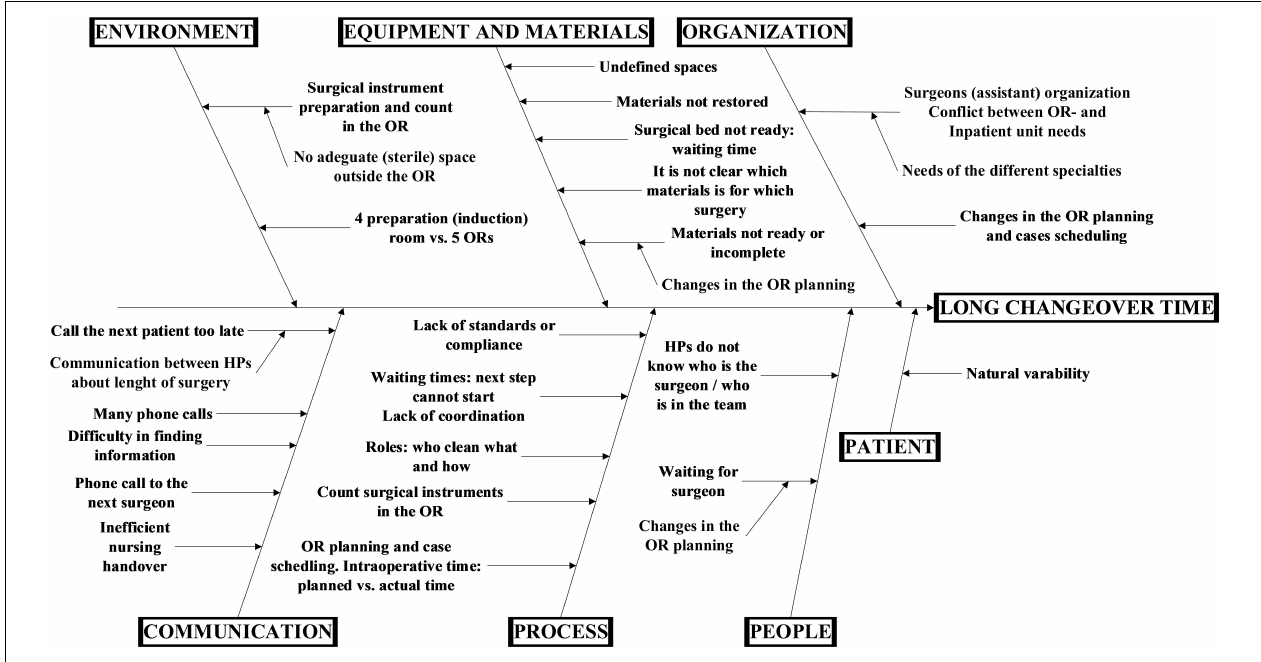
FIGURE 2 | Example of changeover process